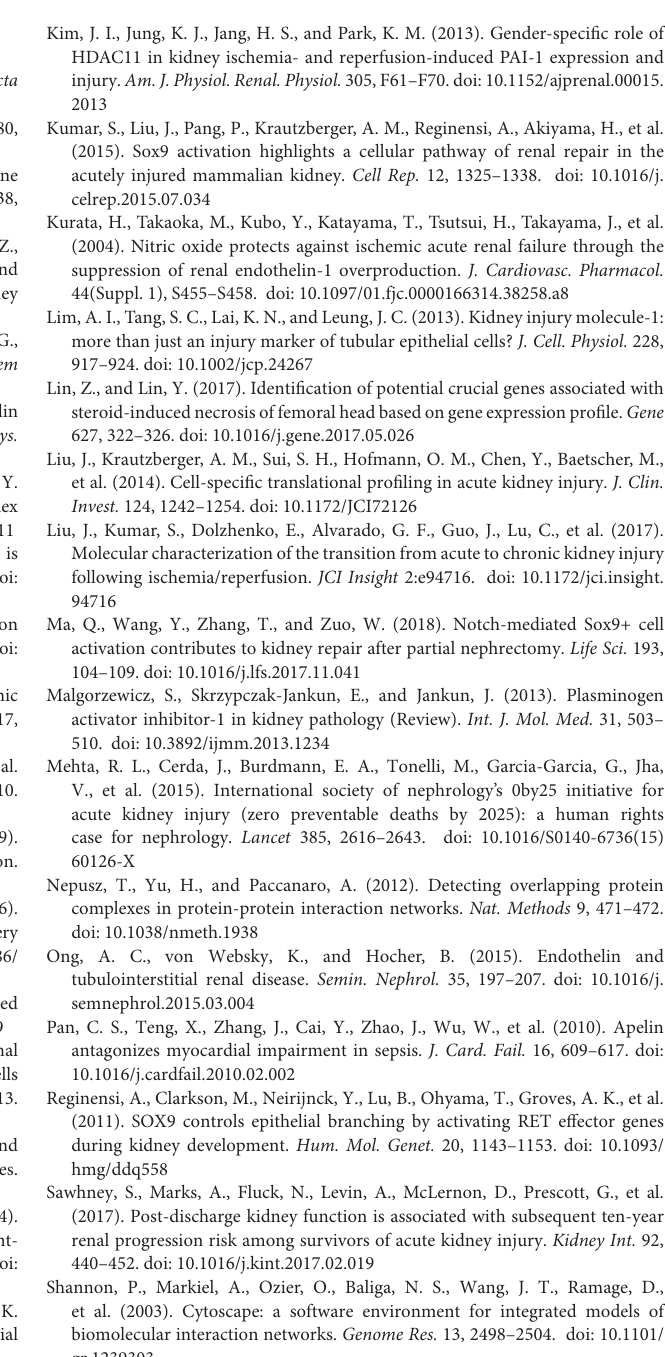
FIGURE S2 | Hierarchical clustering map of the top 50 up-regulated DEGs and the top 50 down-regulated DEGs in four GroupSets. (A) GroupSet A data, (B) GroupSet B data, (C) GroupSet C data, and (D) GroupSet D data. The red rectangle represents up-regulated genes; the green rectangle represents down-regulated genes. Each row represents a single gene; each column represents a tissue sample. DEGs, differentially expressed genes. TABLE S1 | All of the differential expression gene information including logFC and FDR in all four GroupSets.